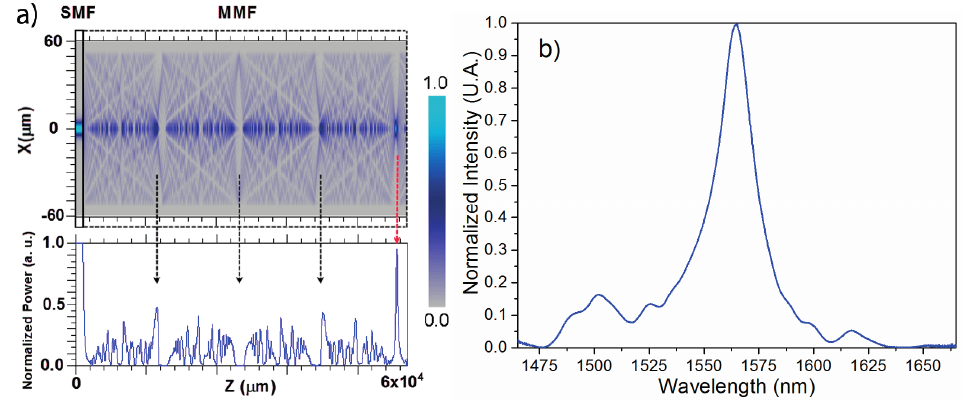
Figure 1. ( a ) Multimode interference phenomenon, ( b ) spectral response of MMI-based